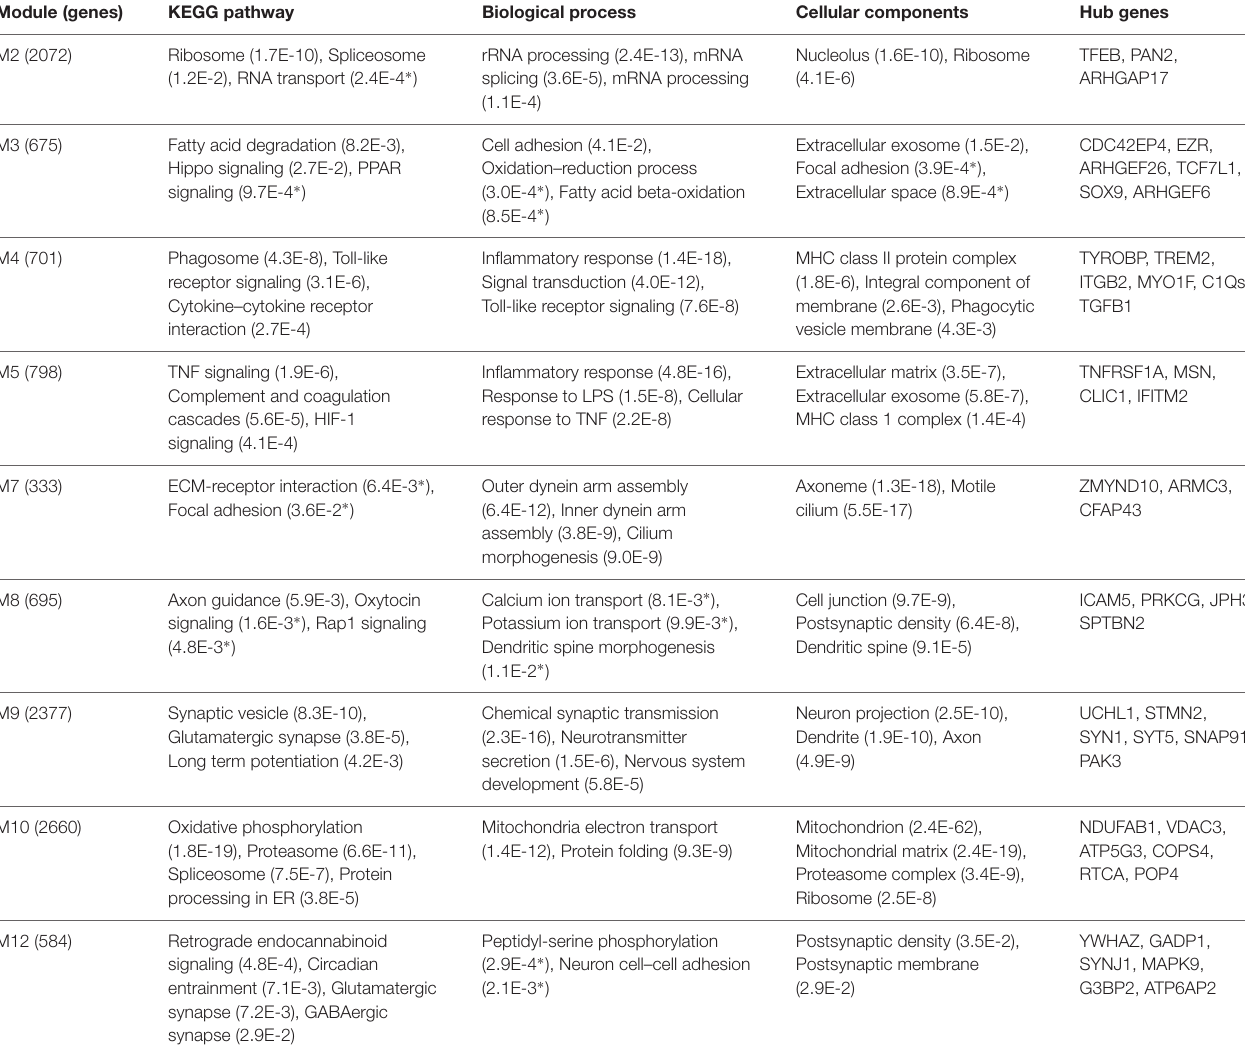
TABLE 2 | Enrichment of Gene Ontology (GO) terms and KEGG pathways associated with aging and AD-specific modules. Module (genes) KEGG pathway Biological process Cellular